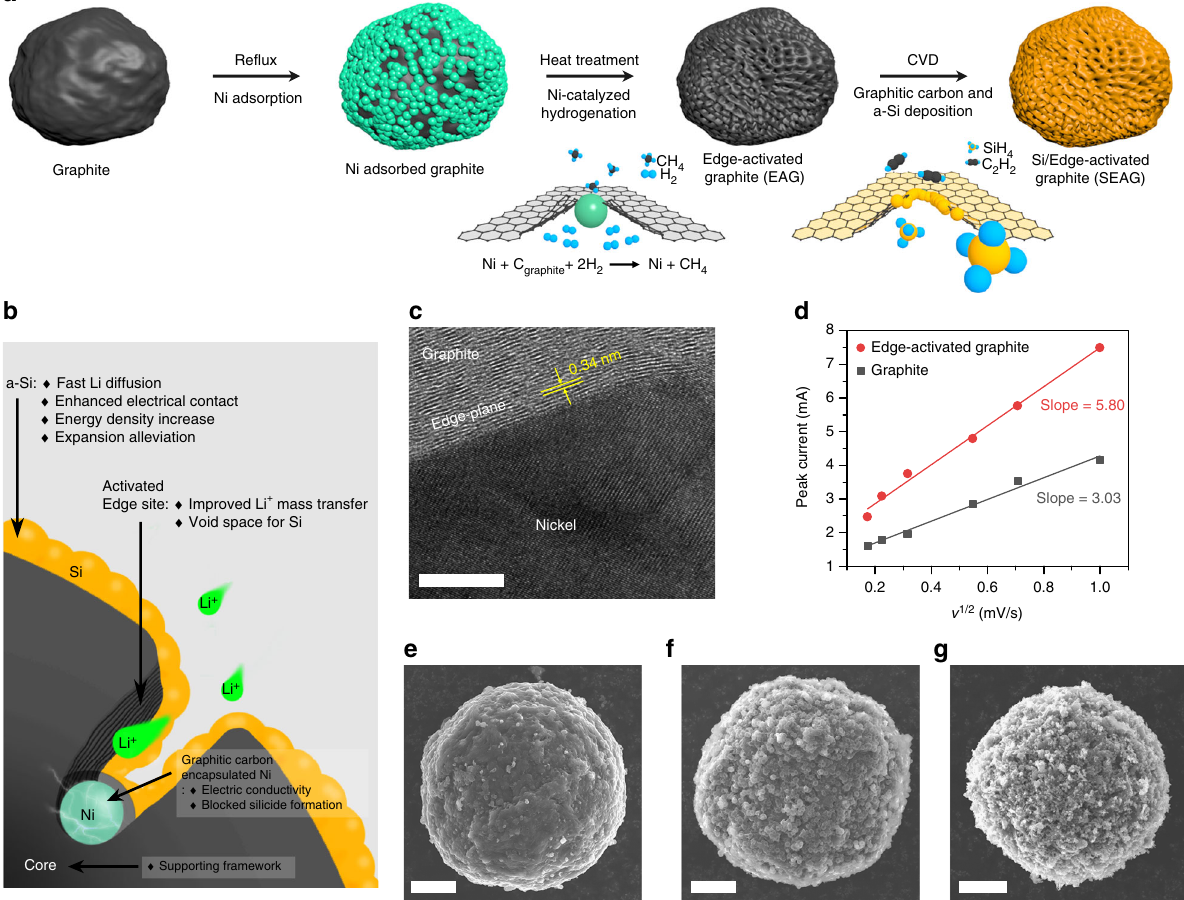
Fig. 1 Schematic of the procedures for fabrication and characterization of SEAG. a Fabrication of SEAG: the adsorbed Ni penetrated graphite via catalytic hydrogenation at 1000 °C, which led to edge-plane activation on the surface of graphite. b Cross-sectional illustration showing the detailed structural characteristics of SEAG. c HR-TEM image of a Ni nanoparticle embedded in EAG. d Relationship between the square root of the scan rate and the peak current: the slope indicates the relative electrochemically active surface area. SEM images of pristine graphite e , graphite with adsorbed Ni on its surface f , and the SEAG composite g . Scale bars, 5 nm c , 5 μ m e , f ,